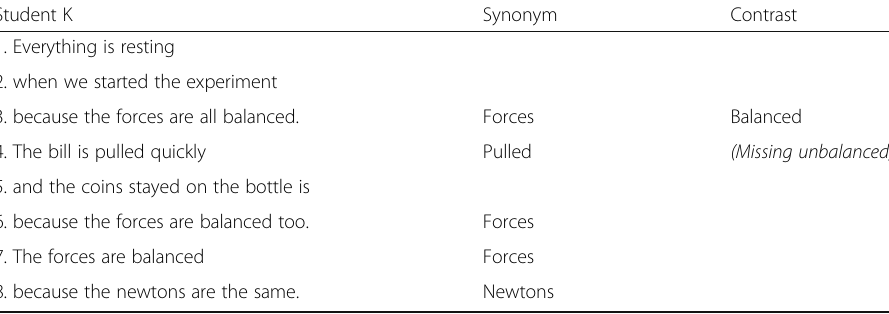
Table 7 Student K ’ s Written Explanation with Lexical Strings; Synonym and Contrast